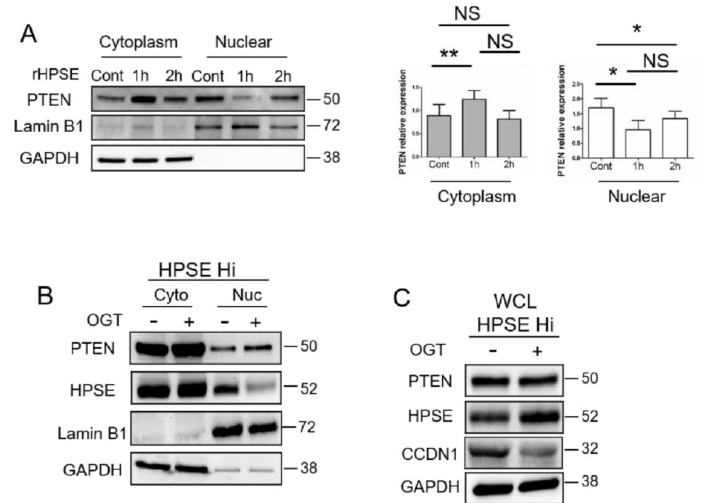
Figure 4. HPSE reduces nuclear PTEN level. ( A ) RPMI-8226 cells were treated with PBS as a control (Cont) or rHPSE (1 µg/mL) for the designated time followed by isolation of cytoplasmic and nuclear fractions. PTEN present in each fraction was assessed by Western blotting. LaminB1 and GAPDH were used as loading control and to assess the quality of the isolated fractions. The bar graphs show the mean relative expression of PTEN normalized with GAPDH for the cytoplasmic fraction or normalized with LaminB1 for the nuclear fraction in three independent experiments. ** p < 0.01 and * p < 0.05; NS—not significant. ( B ) CAG HPSE Hi cells were treated with OGT2115 and the levels of PTEN and HPSE present in the cytoplasmic and nuclear fractions were evaluated by Western blot. LaminB1 and GAPDH were utilized for assessing the quality of the fractions. ( C ) HPSE Hi cells were incubated without or with the heparanase inhibitor OGT2115 for 16h. PTEN, CyclinD1 (CCND1) and HPSE expression were evaluated in whole cell lysates (WCL) by Western blot.